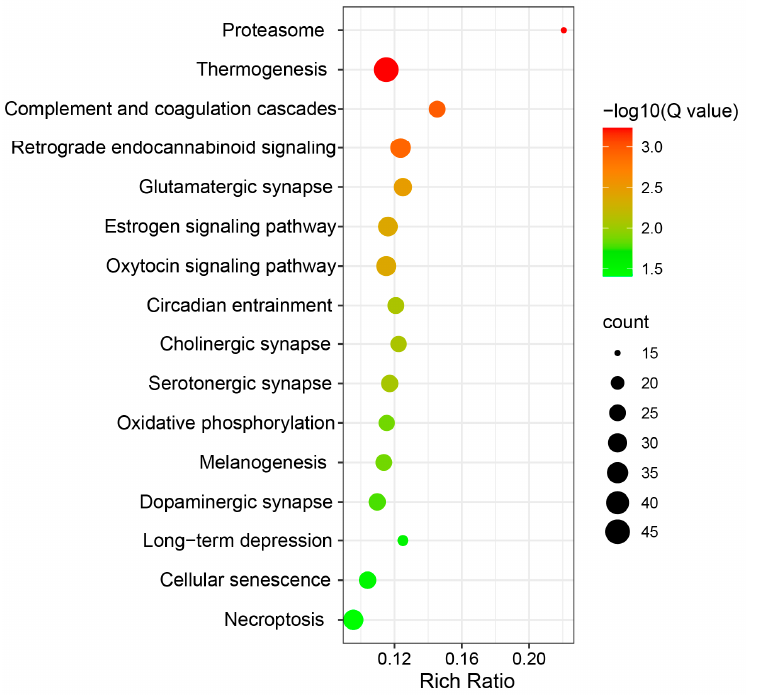
Figure 3. Significantly enriched KEGG pathways of DEGs ( Q -value < 0.05). The abscissa represents the rich ratio, and the ordinate represents the pathway name. Table 2. The fat-metabolism-related DEGs in the livers of Hu sheep vs. Tibetan sheep.